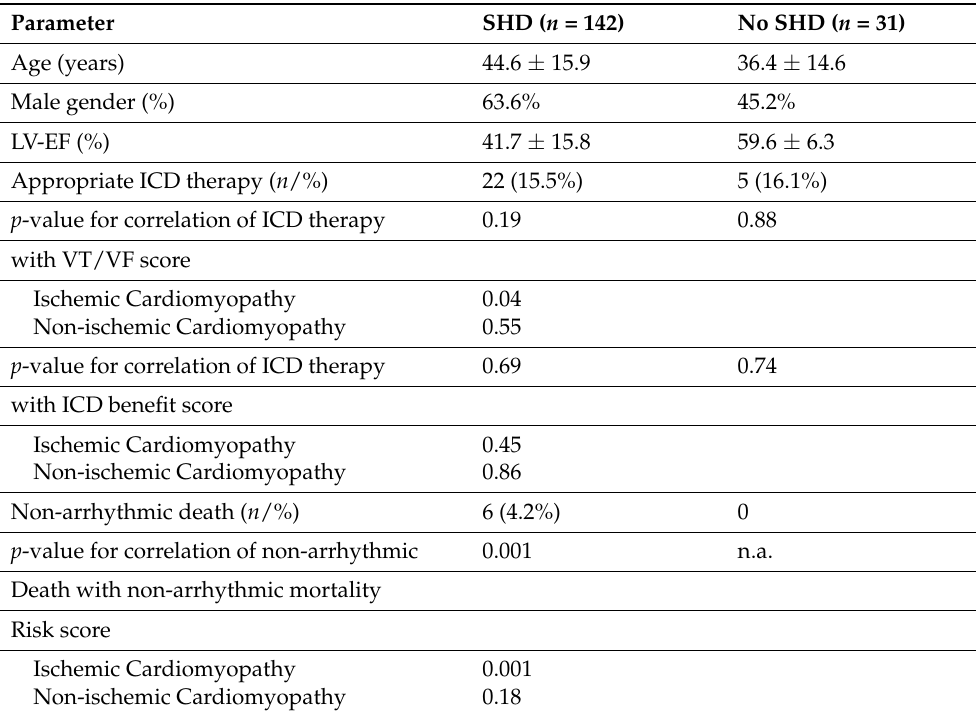
Table 3. Comparison of the patients with and without structural heart diseases (SHD) within the